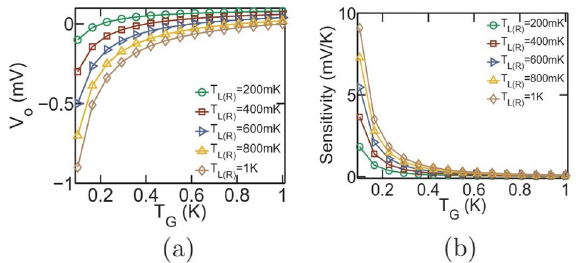
Figure 2. Voltage based thermometry in the dual-dot set-up depicted in Fig. 1a. Variation in ( a ) Open-circuit voltage ( b ) temperature sensitivity (cid:31) dV o dT with T G for different values of T L ( R ) . For the above set of plots, the G (cid:30) value of Coulomb coupling energy is chosen as U m = 100 µ eV and the ground states are pinned at the equilibrium Fermi energy, that is, ξ 1 s = ξ g = µ 0 . The open-circuit voltage as well as temperature sensitivity dV o T L ( R ) . (cid:31) dT G (cid:30) in the set-up under consideration is dependent on